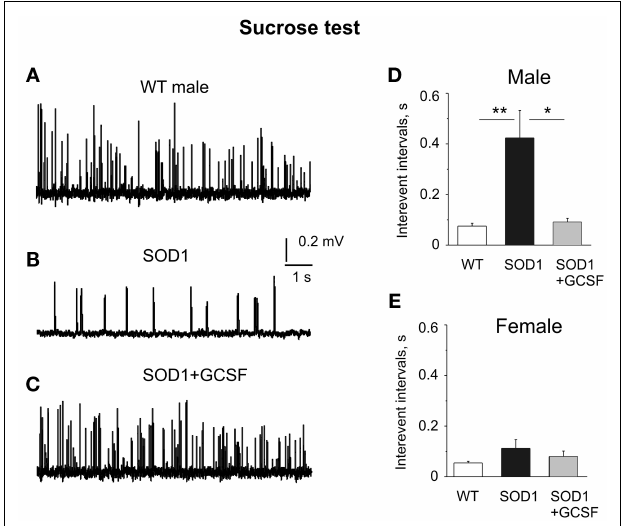
FIGURE 3 | Interevent intervals of spontaneous MEPPs at the neuromuscular junctions ofWT, G93A-SOD1, and GCSF-treated G93A-SOD1 mice. (A,B) . Histograms showing mean interevent intervals of MEPPs (left axis) in theWT, G93A-SOD1, and GCSF-treated G93A-SOD1 male (A) and female (B) mice. Each dash line indicates individual synapse (right axis). Note huge variability of release probabilities between individual synapses. ** = P < 0.01, *** = P < 0.001.